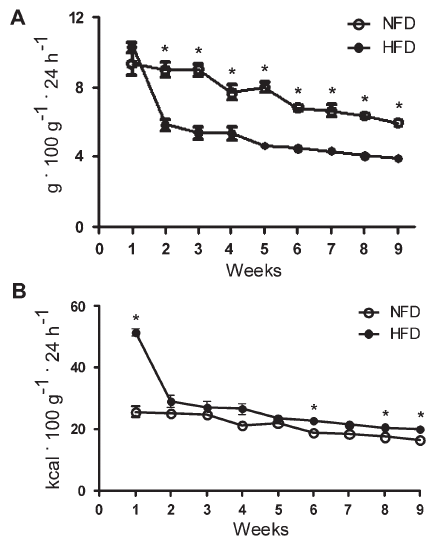
Figure 2. A , Food intake (g ? 100 g -1 ? 24 h -1 ) and B , energy intake (kcal ? 100 g -1 ? 24 h -1 ) of normal fat diet (NFD; n=16) and high-fat diet (HFD; n=71) groups during obesity-induction period. *P , 0.05 vs NFD (Student t -test).